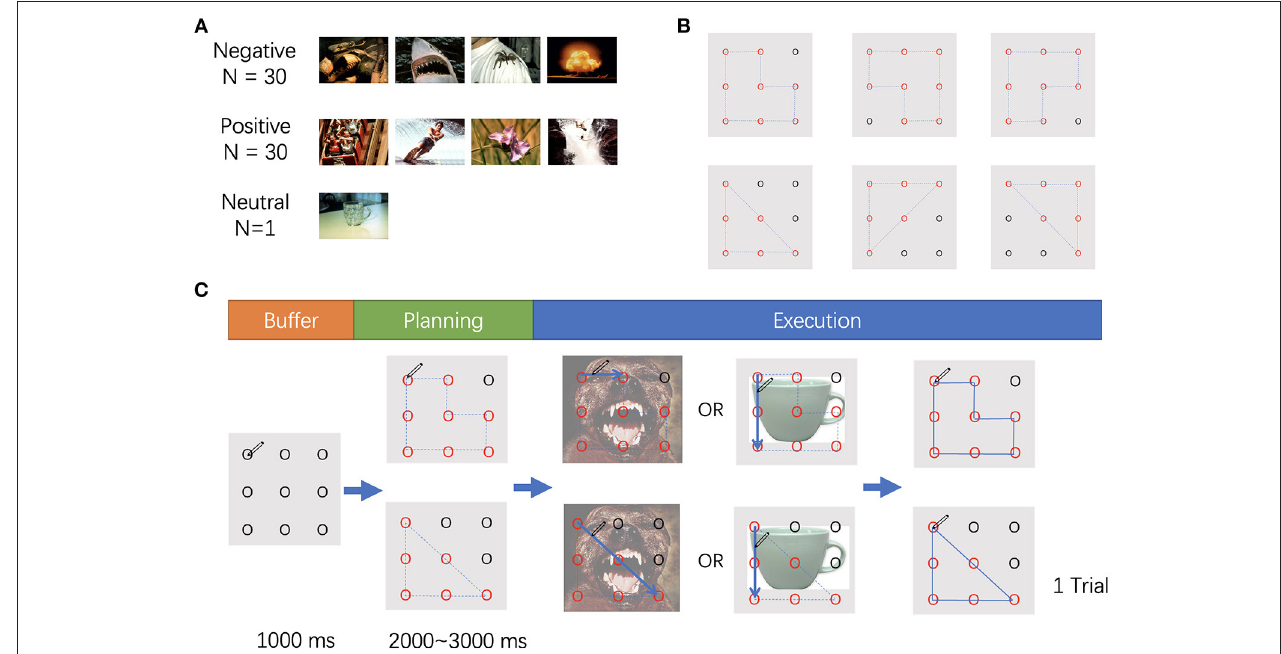
FIGURE 1 | (A) Samples of stimuli used in the experiment. (B) The movements used in the experiment. (C) The procedure of the